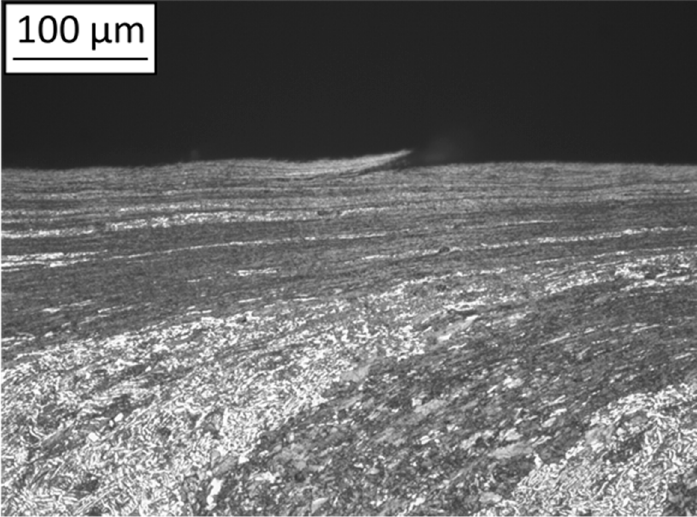
Figure 5. Cross-section of the wheel disc T02 at the end of the stepwise test (200,000 cycles).